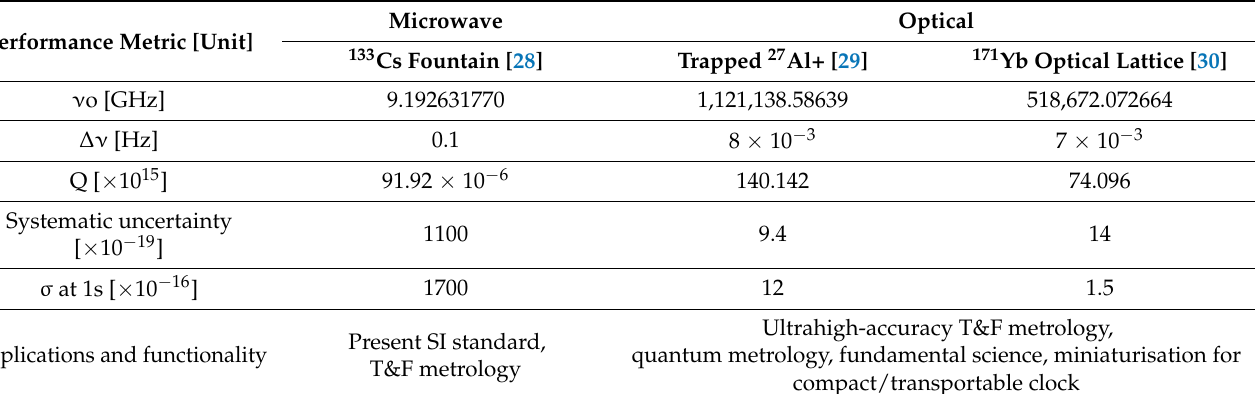
Table 1. Typical parameters and performance metrics of microwave-based caesium (Cs) fountain and optical atomic clocks using a single trapped aluminium ion ( 27 Al+) and neutral ytterbium atoms ( 171 Yb) in an optical